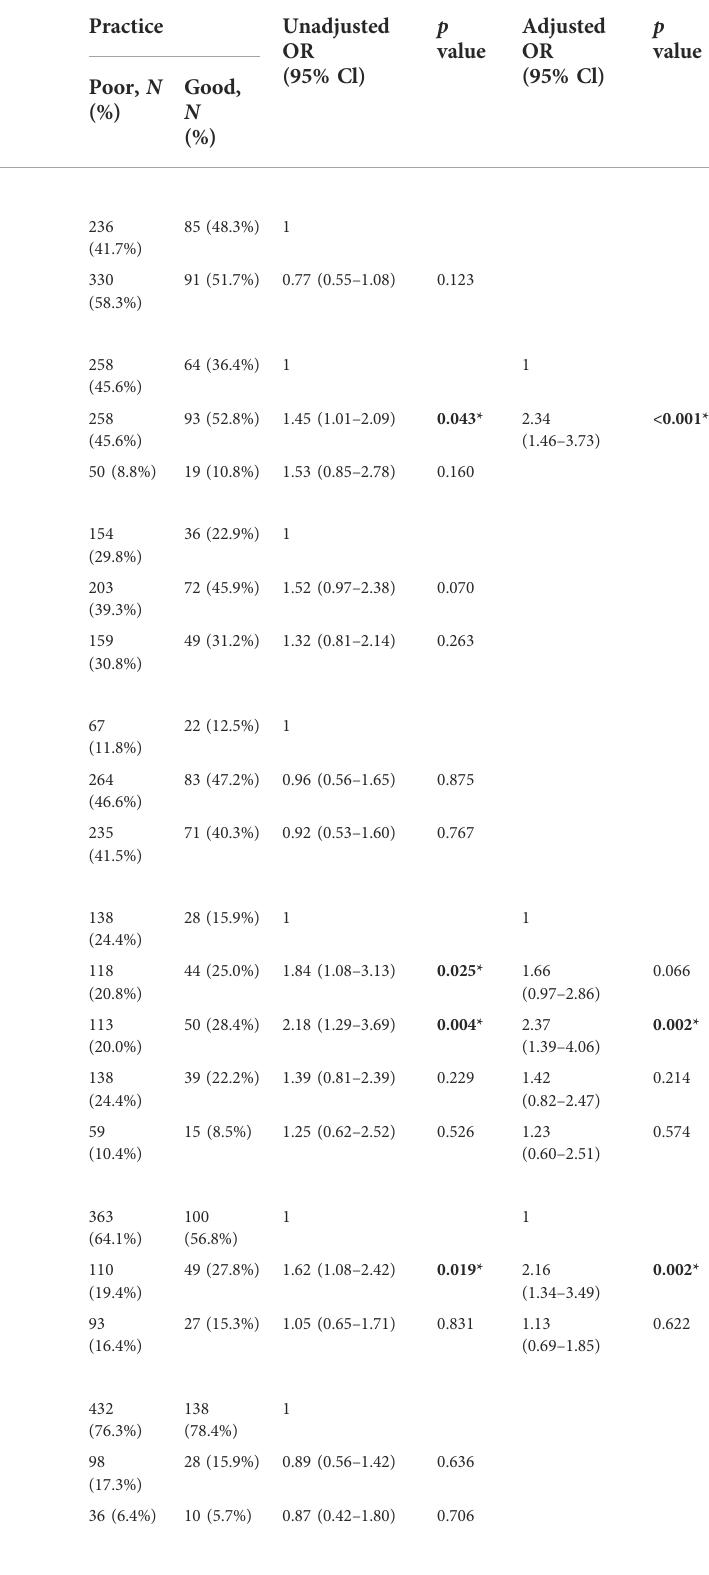
TABLE 4 Univariable and multivariable analysis of associated factors of HCPs ’ practice towards NCDP